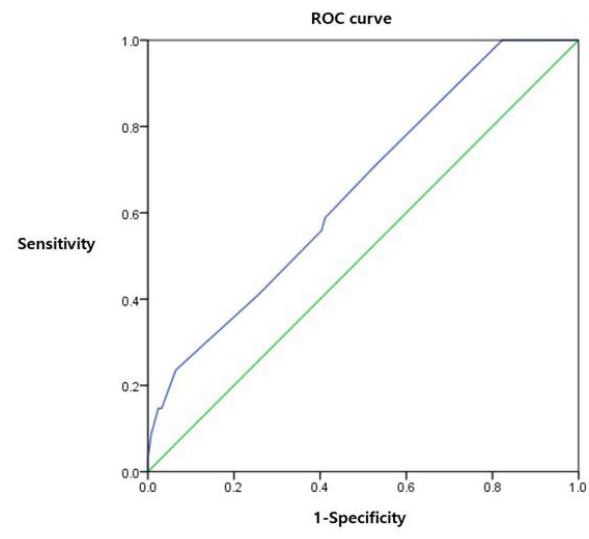
Figure 2. The receiver operating characteristic curve (ROC) was drawn to assess the ability of the COLDS score to predict perioperative respiratory adverse events (PRAEs). Table 2. Demographic information of low COLDS group (Group L) and high COLDS group (Group H) after propensity